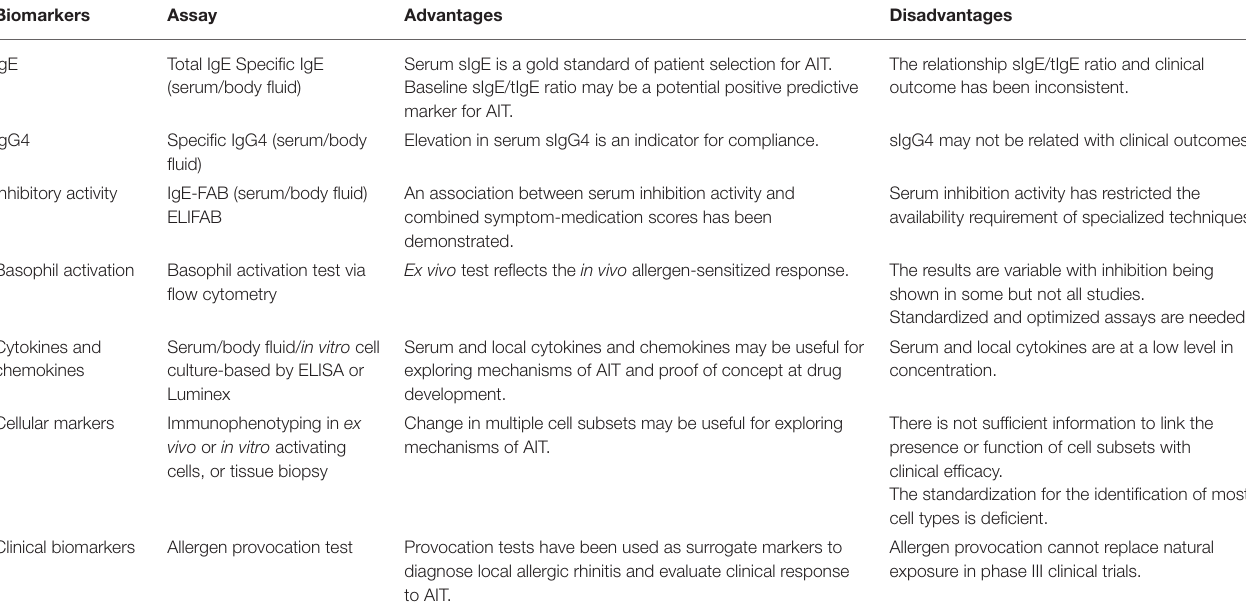
TABLE 1 | The implementation of biomarkers in allergen-specific immunotherapy (AIT).